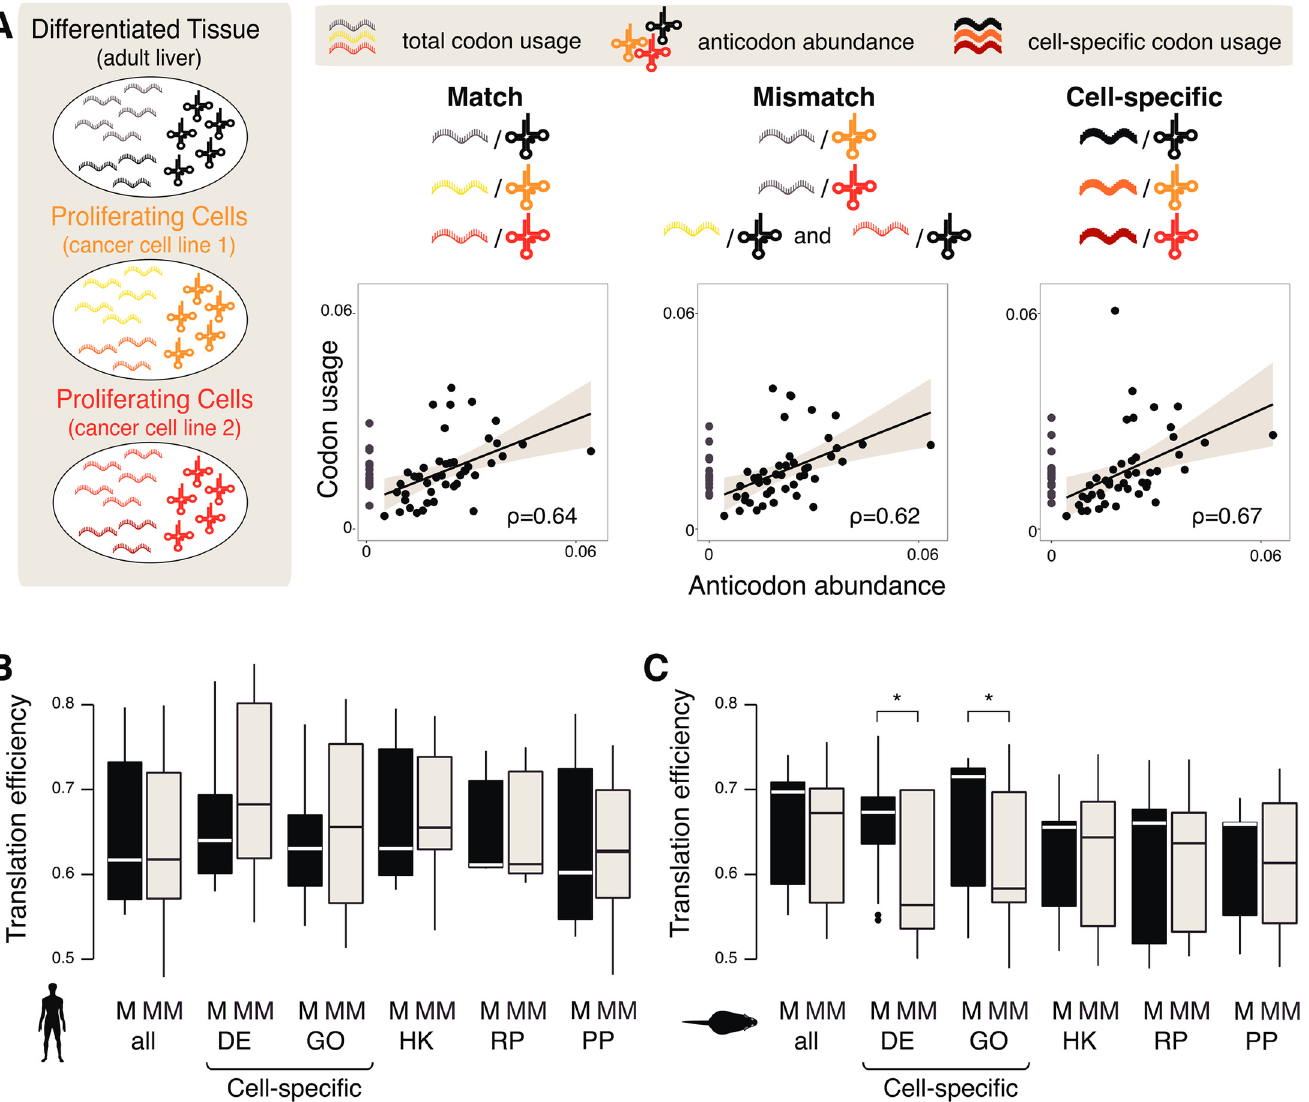
Fig 3. Correlation of codon usage and tRNA abundance shows no consistent evidence of translational adaptation. ( A ) Schematic representation of the codon – anticodon relationship for each color-coded cell type. Comparisons were performed for “ Match (M) ” : between global codon and anticodon abundances from the same cell type; “ Mismatch (MM) ” : between codon abundance from one cell type and anticodon abundance from a different cell type; and “ Cell-specific ” : between codon abundance for a subset of genes and anticodon abundance for all conditions (encompassing both match and mismatch). Examples for each comparison are shown by plotting proportional frequencies of Pol III binding to tRNA anticodons (x-axis) and transcriptomic codon frequencies weighted by expression levels (y-axis) obtained from RNA-seq data. Spearman ’ s rank correlation coefficients ( ρ ) are indicated. Anticodons for which there are no corresponding tRNA genes (gray dots) were excluded when calculating the correlation coefficients. The gray area within plots represents the 95% confidence interval. Boxplots show the resulting codon – anticodon correlations for all pairwise comparisons for ( B ) human and ( C ) mouse. “ Match ” , “ Mismatch ” and “ Cell-specific ” samples were correlated as in ( A ). Translational efficiencies are shown as correlations of the codon pool for all genes ( “ all ” ), the 200 most highly differentially expressed ( “ DE ” ) protein-coding genes, condition-specific gene ontology ( “ GO ” ) term gene sets, house-keeping ( “ HK ” ), ribosomal ( “ RP ” ) or proliferation-driving ( “ PP ” ) protein encoding genes with either the anticodon pool of the same condition ( “ M ” ) or any other condition ( “ MM ” ). Asterisks above the bars indicate significant differences (one-tailed Mann – Whitney – Wilcoxon test; significance codes Bonferroni-corrected p -values: 0 – 0.001 *** , 0.001 – 0.01 ** , and 0.01 – 0.05 * ) for a given